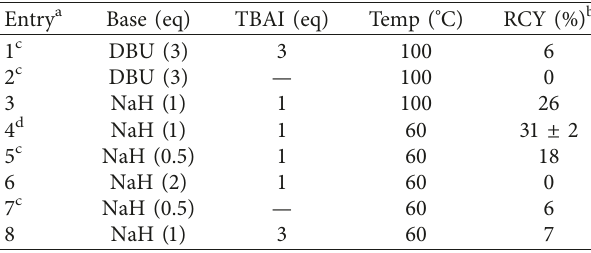
Table 1: Optimisation of [ 11 C] 1 synthesis. Table 2: Optimisation of [ 11 C] 1 synthesis using alternative